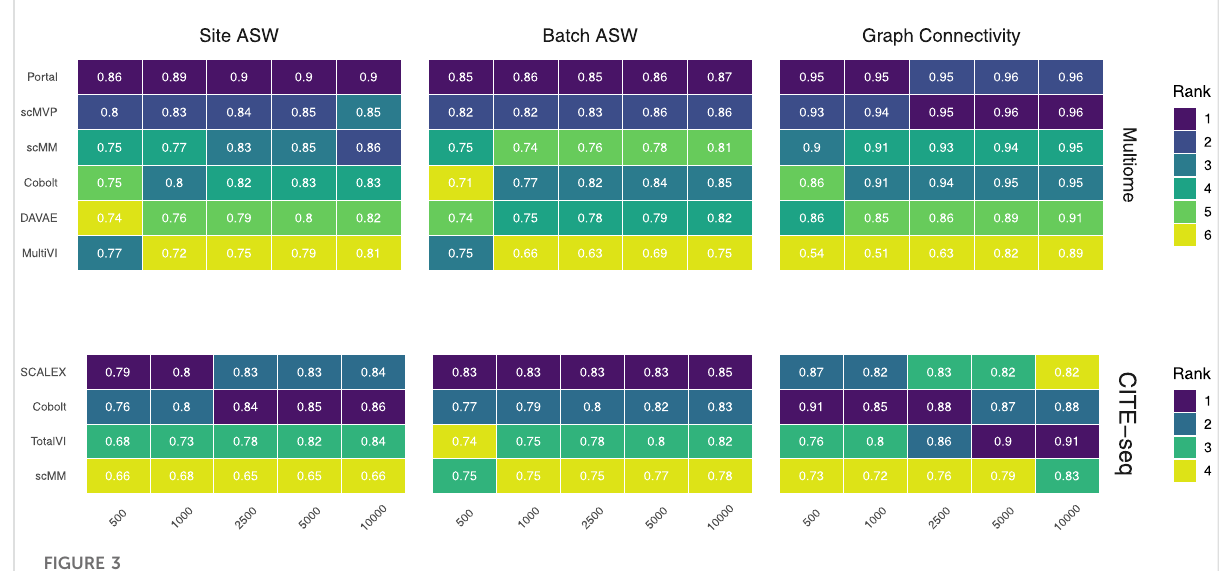
FIGURE 3 Technical effect removal metrics. Site ASW, batch ASW, and graph connectivity score indicate the quality of technical effects removal achieved byjointembeddingsfromvariousmodels.Onthe10xMultiomedata,theperformanceofPortal,scMVP,scMM, Cobolt,DAVAE,andMultiVIisshown (top), whereas the performance on CITE-seq data is shown for the SCALEX, Cobolt, TotalVI, and scMM (bottom). Median scores across all iterations are shown inside the